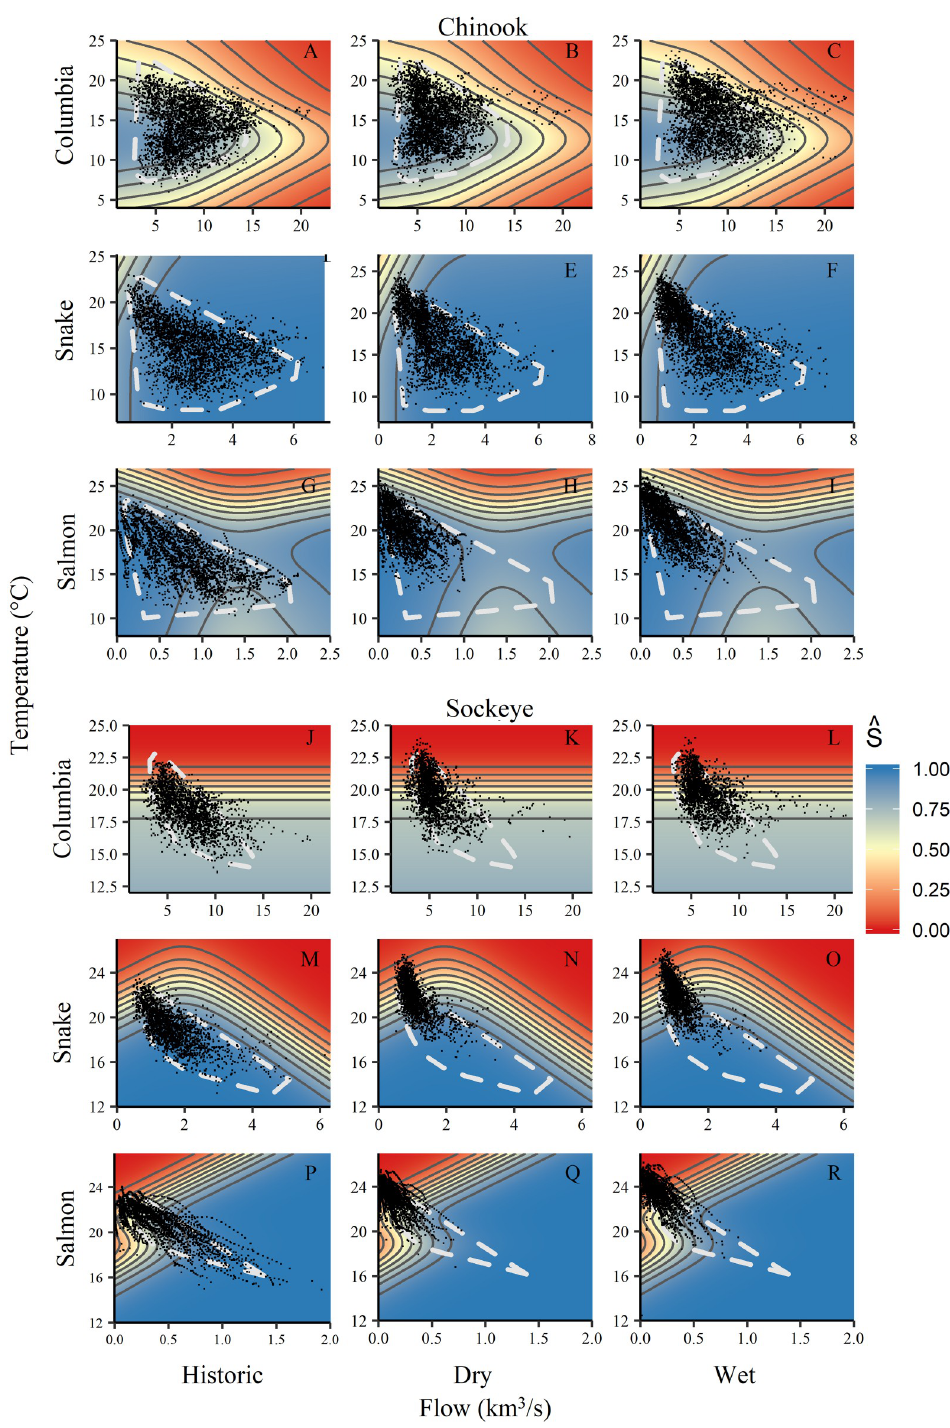
Fig 7. Apparent survival surfaces as a function of temperature and flow from Fig 3 overlaid with simulated fish in the historical, dry, and wet climate scenarios (columns). White polygons show the range of environmental conditions in the observation dataset (from Fig 3) for comparison to the distribution of points in the climate simulations (black). Although some simulated fish experienced temperatures and flows that were outside the range of our observation dataset, the majority of simulated fish experienced conditions within those observed in the retrospective analyses (i.e., most points are inside the polygons). There was also a loss of low temperature and high flow